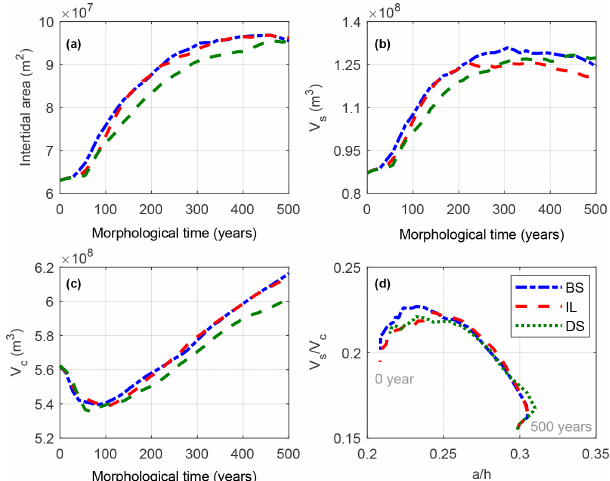
Figure 12. The cross-sectional average velocity over a tidal cycle of different scenarios after (a) 0 years, (b) 300 years and (c) 500 years. The flood tidal velocity is positive. Figure 13. Temporal variation of intertidal flat area (a) , intertidal storage volume (b) , channel volume (c) and the ratio of V s /V c in the inner basin of different island